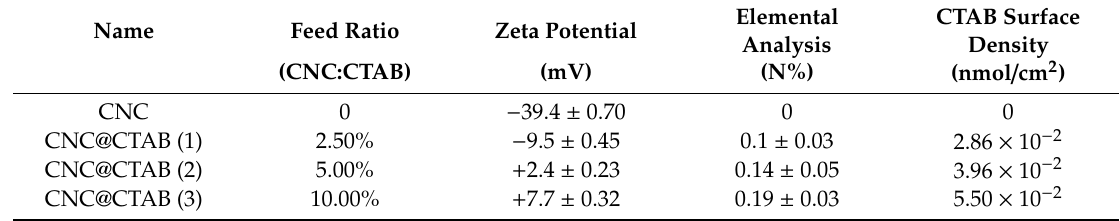
Table 1. Zeta potential and Elemental analysis of the CNC and CNC@CTAB.